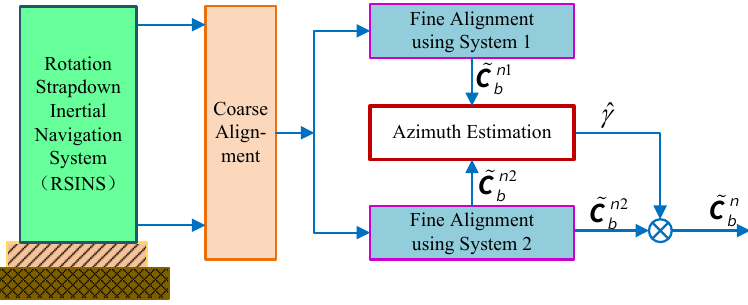
Figure 7. The schematic diagram of the DMCS-based alignment